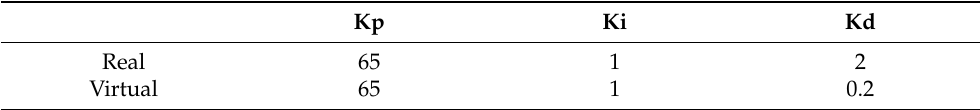
Table 2. Values of the PID in the real and virtual